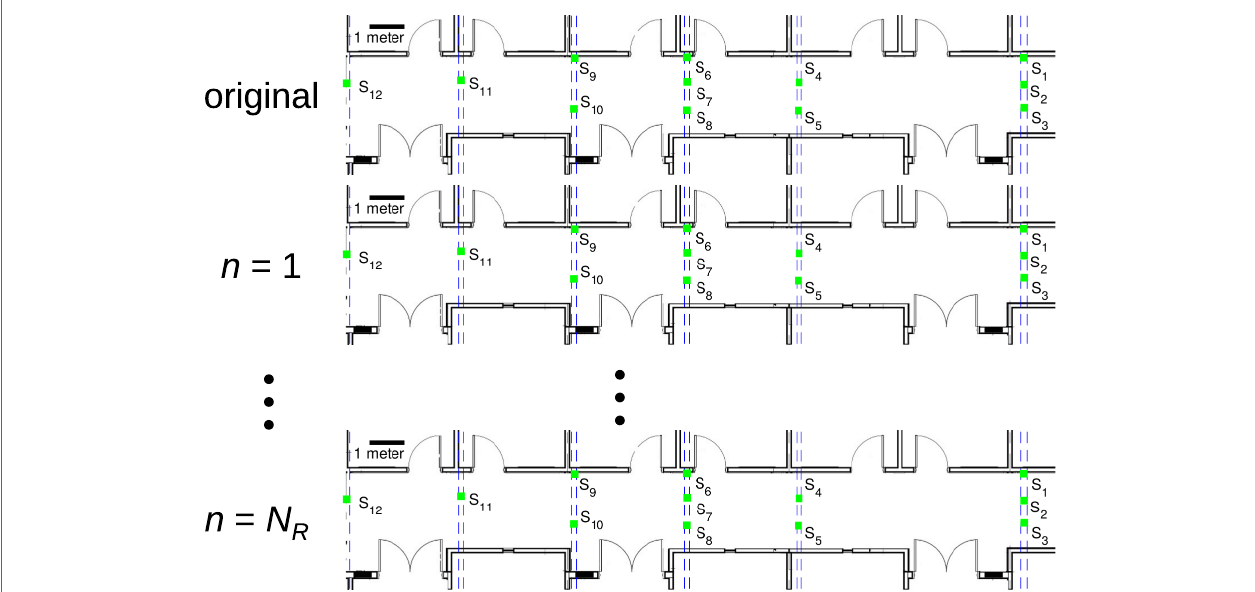
FIGURE 8 | Method of generating a large floor plan by replicating the original Goodwin Hall test area N R times, each replication translated South (downward on the page) first from the original and thereafter from the prior replication to avoid overlap.